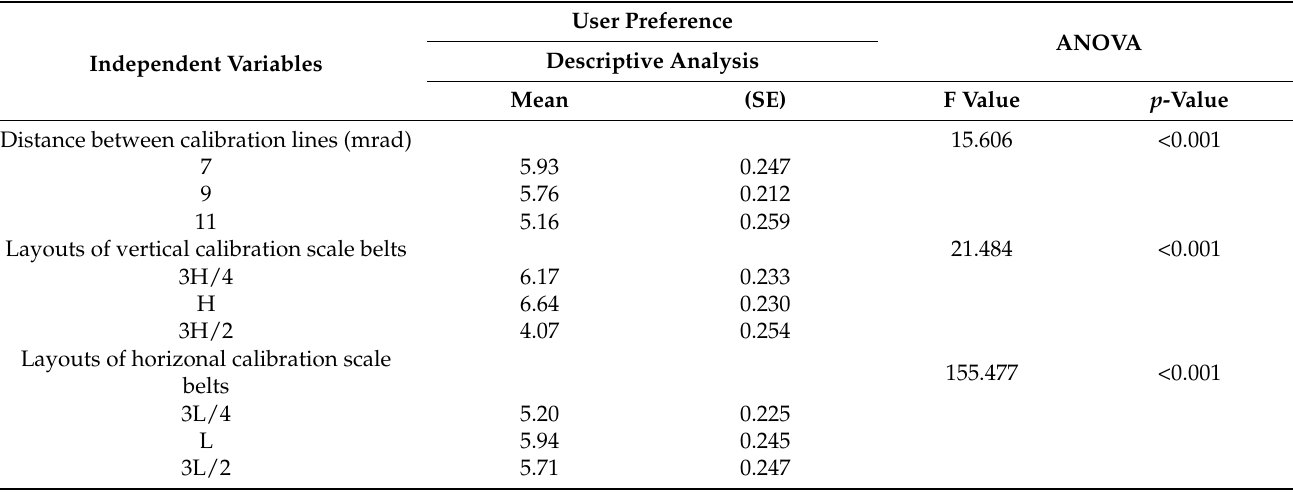
Table 5. Main effects of distance between calibration lines and layouts of vertical and horizonal calibration scale belts on user preference.